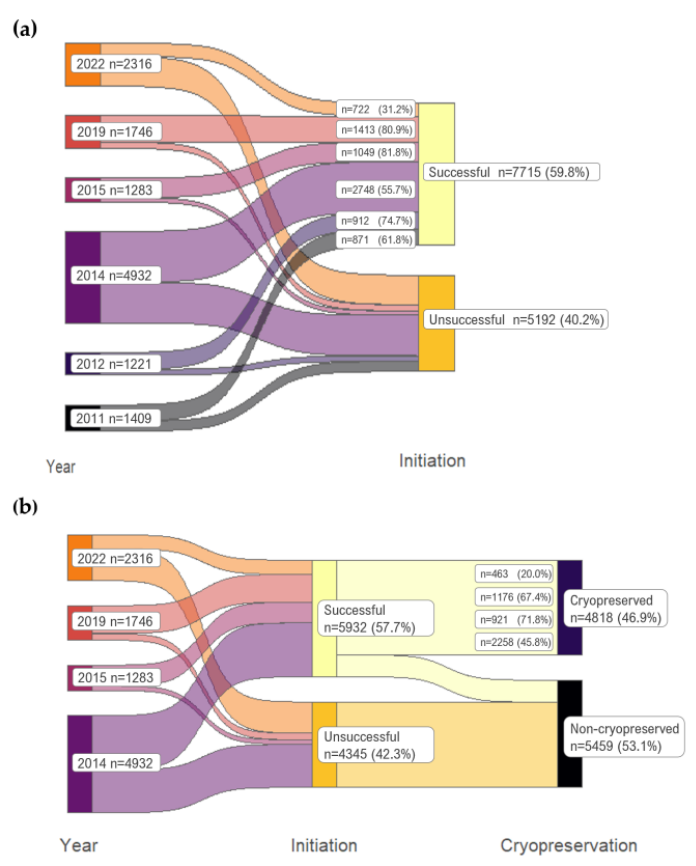
Figure 1. Sankey diagram of Norway spruce initiation success ( a ) and cryopreserved ET ( b ) percent- ages in different years. n = the number of initiations.